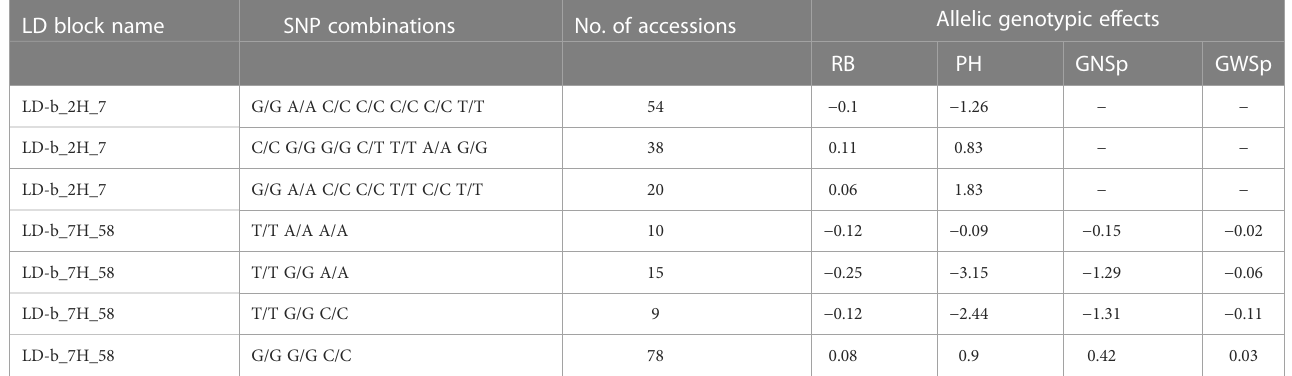
TABLE 7 Characterization of signi fi cant root-related LD blocks also associated with other